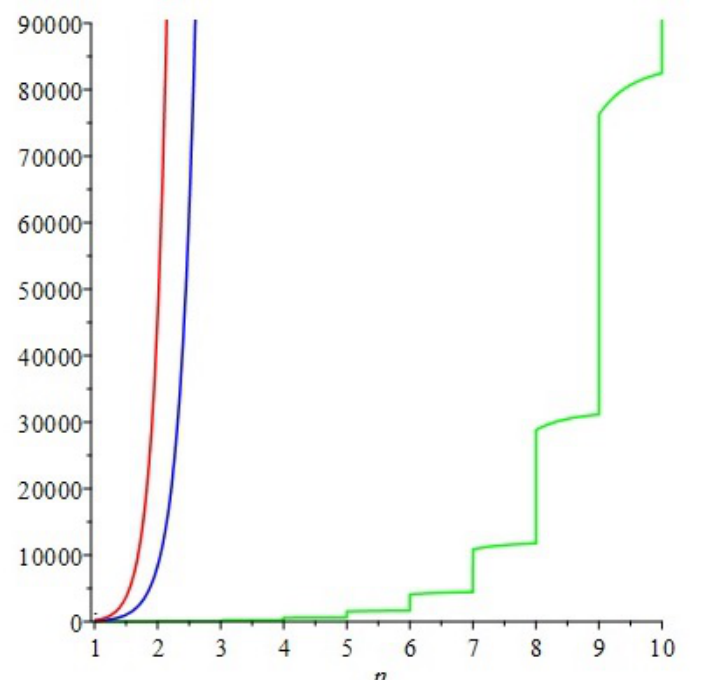
Figure 6. Graphical Comparison of indices of CCC ( 1 ) ; ξ ( G ) is red, C ξ ( G ) is blue, and ECP ( G , x ) is